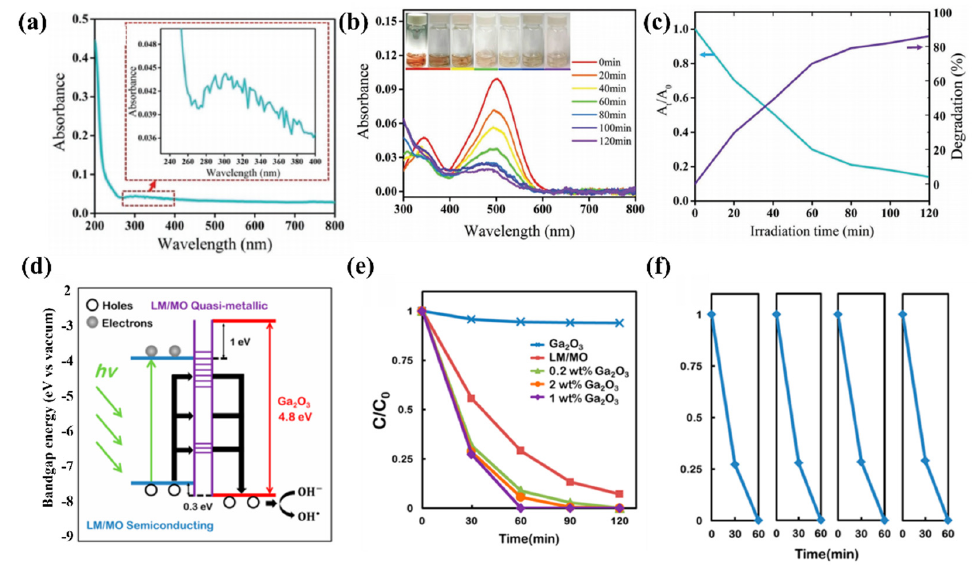
Figure 7. ( a ) The nanosheet material stripped from liquid metal ( b ) The changing trend of the absorption spectrum and CR’s degradation process ( c ) CR relative absorbance (A t /A 0 ) and dye degradation rate. Reprinted with permission from Ref. [92] Copyright 2017 Advanced functional materials. ( d ) Band structure diagram of the combined system ( e ) Degradation of 10 μ M CR in the presence of LM/MO frameworks incorporated with different loadings of Ga 2 O 3 nanoparticles ( f ) Degradation of 10 μ M CR in the presence of one sample of LM/MO frameworks with 1wt % incorporated Ga 2 O 3 in four consecutive cycles. Reprinted with permission from Ref. [93] Copyright 2015 ACS Applied Materials & Interfaces.